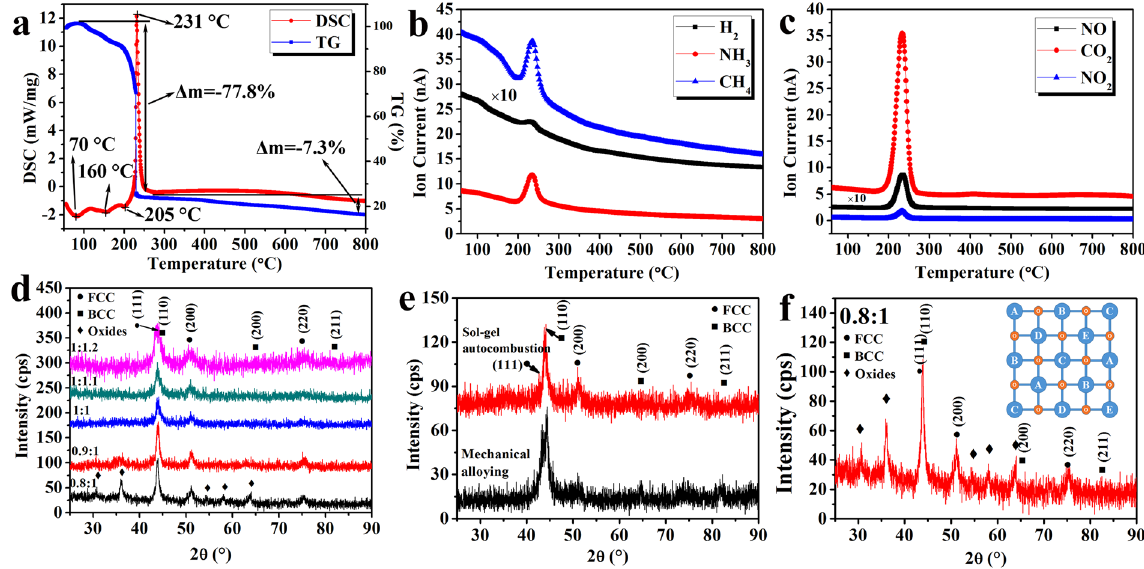
Figure 1. ( a – c ) TG–DSC–MA results obtained for the dried gel prepared from the sol with a fuel–oxidant ratio of 1:1; ( d ) XRD patterns revealing the crystal structures of the combustion products of the dried gels for different fuel-oxidant ratios; ( e ) comparison of XRD patterns of CoCrCuNiAl HEAs synthesized by sol–gel autocombustion and MA; ( f ) XRD patterns of the combustion product of the gels with a fuel–oxidant ratio of 0.8:1 and the schematic illustration of